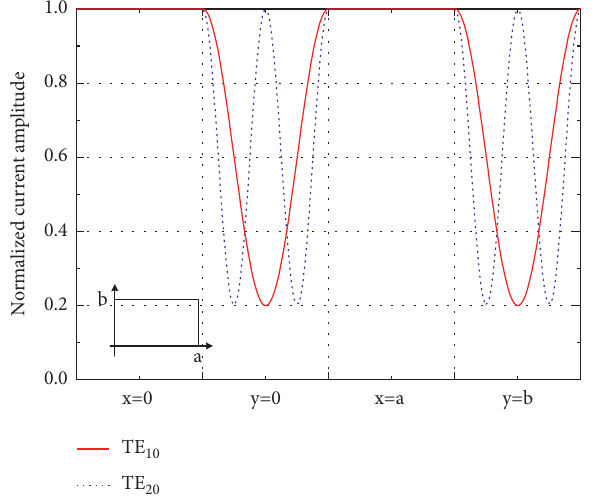
Figure 3: Normalized current amplitude.